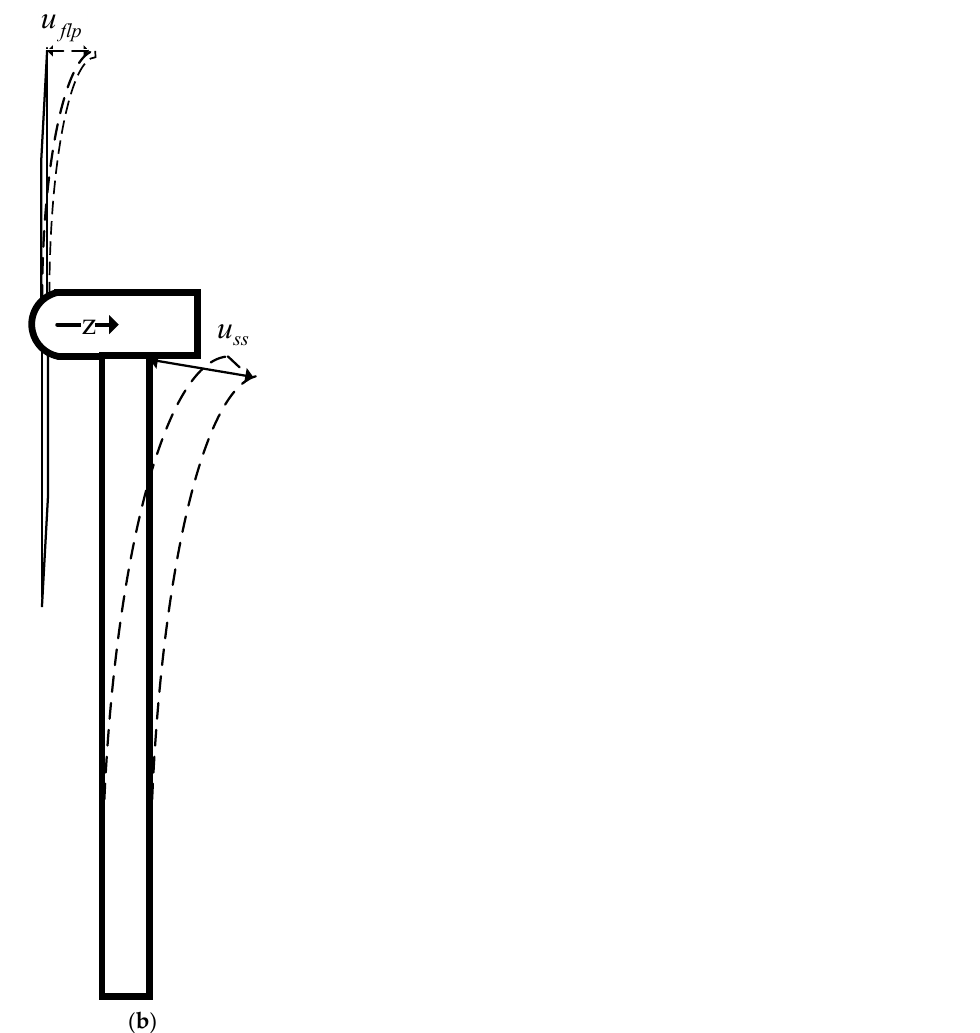
Figure 3. Schematic view of blade and tower. ( a ) front view of the wind turbine. ( b ) side view of the wind turbine.